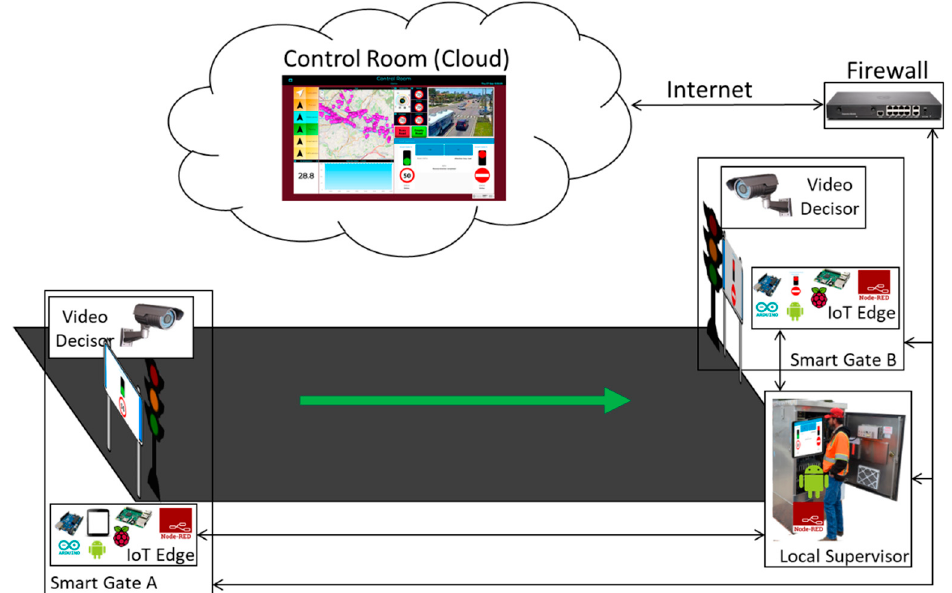
Figure 5. Configuration of a one-way variable system on a road segment.